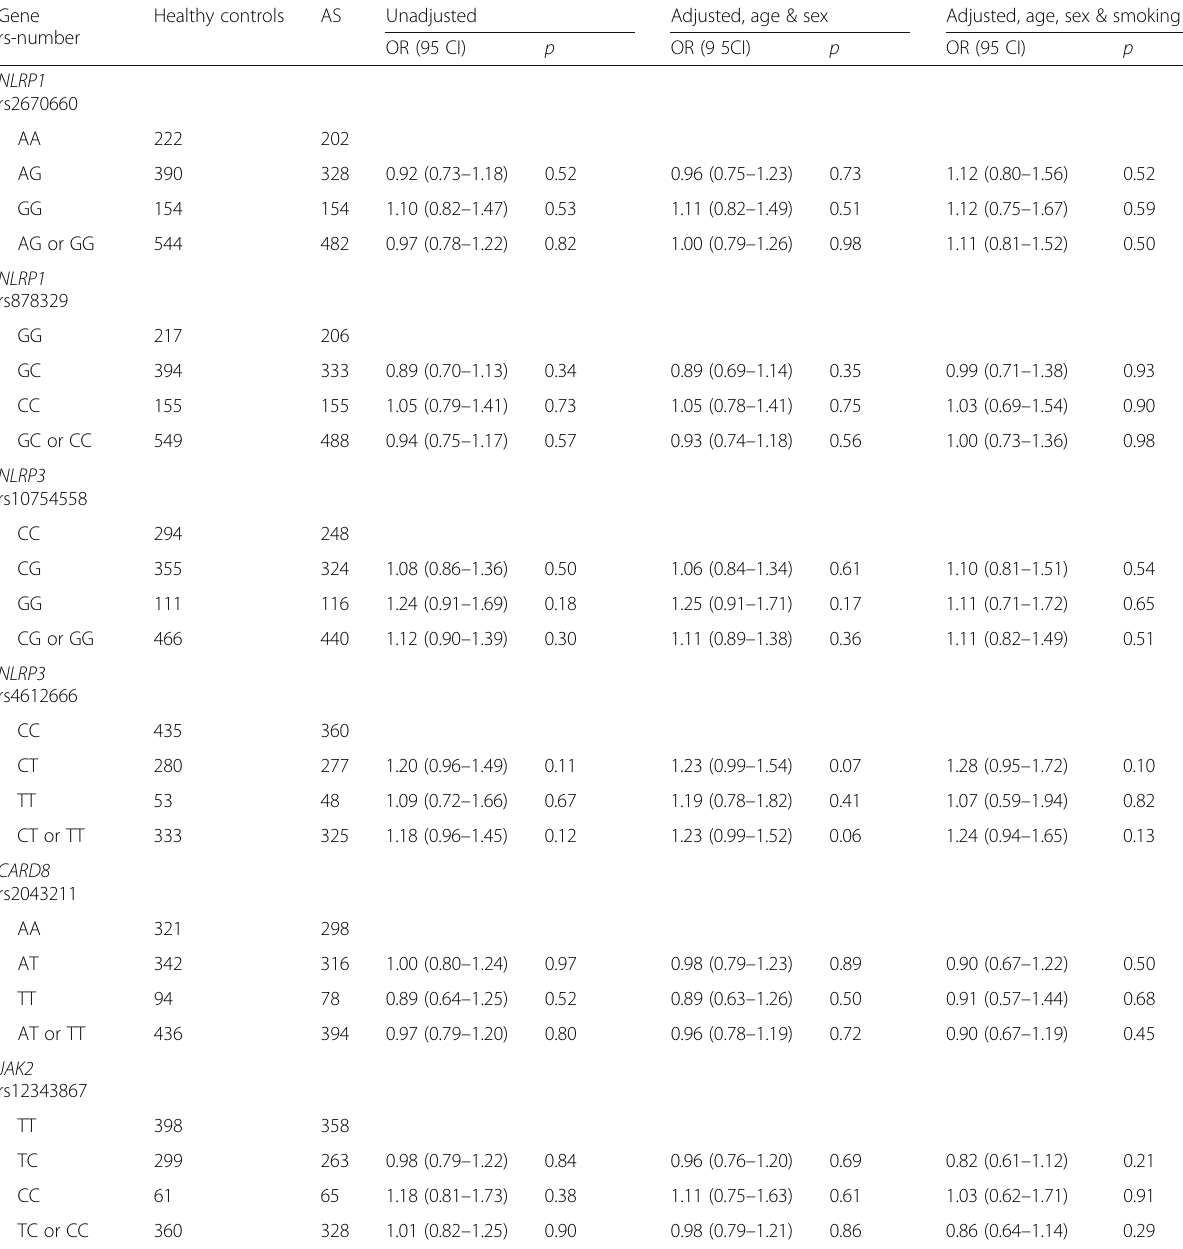
Table 1 Odds ratios (OR) and 95% confidence interval (95CI) for genotypes studied among healthy controls and patients with ankylosing spondylitis (AS)